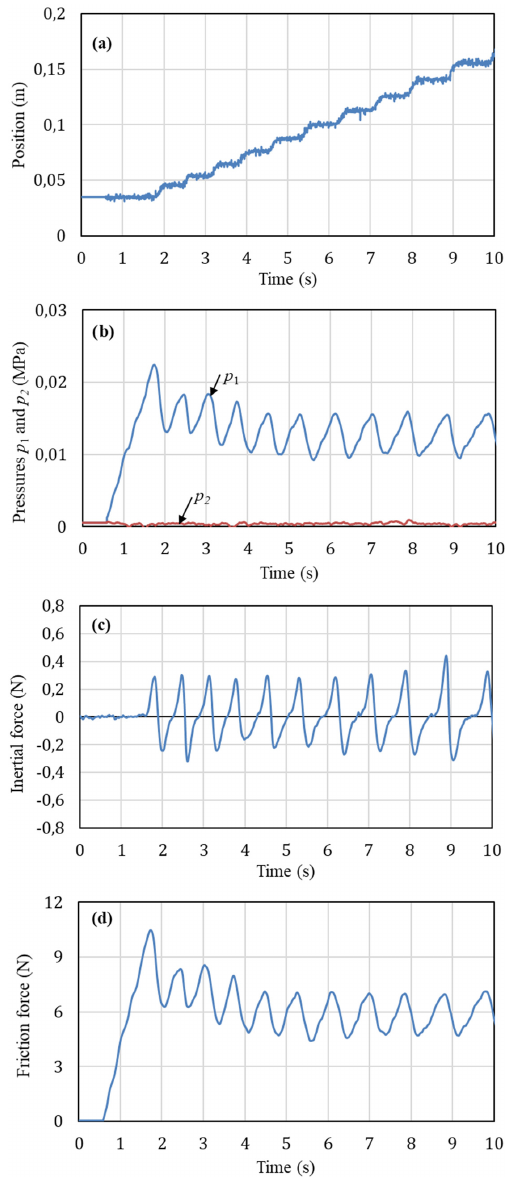
Figure 7. Experimental characteristics at operating conditions of u 1 = 2 . 875V, u 2 = 2 . 19V and M = 1 . 3kg: (a) piston position, (b) pressures in the cylinder chambers, (c) initial force, (d) friction